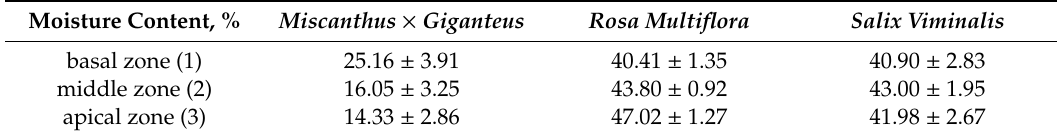
Table 3. The average moisture content in individual zones of energy crops.